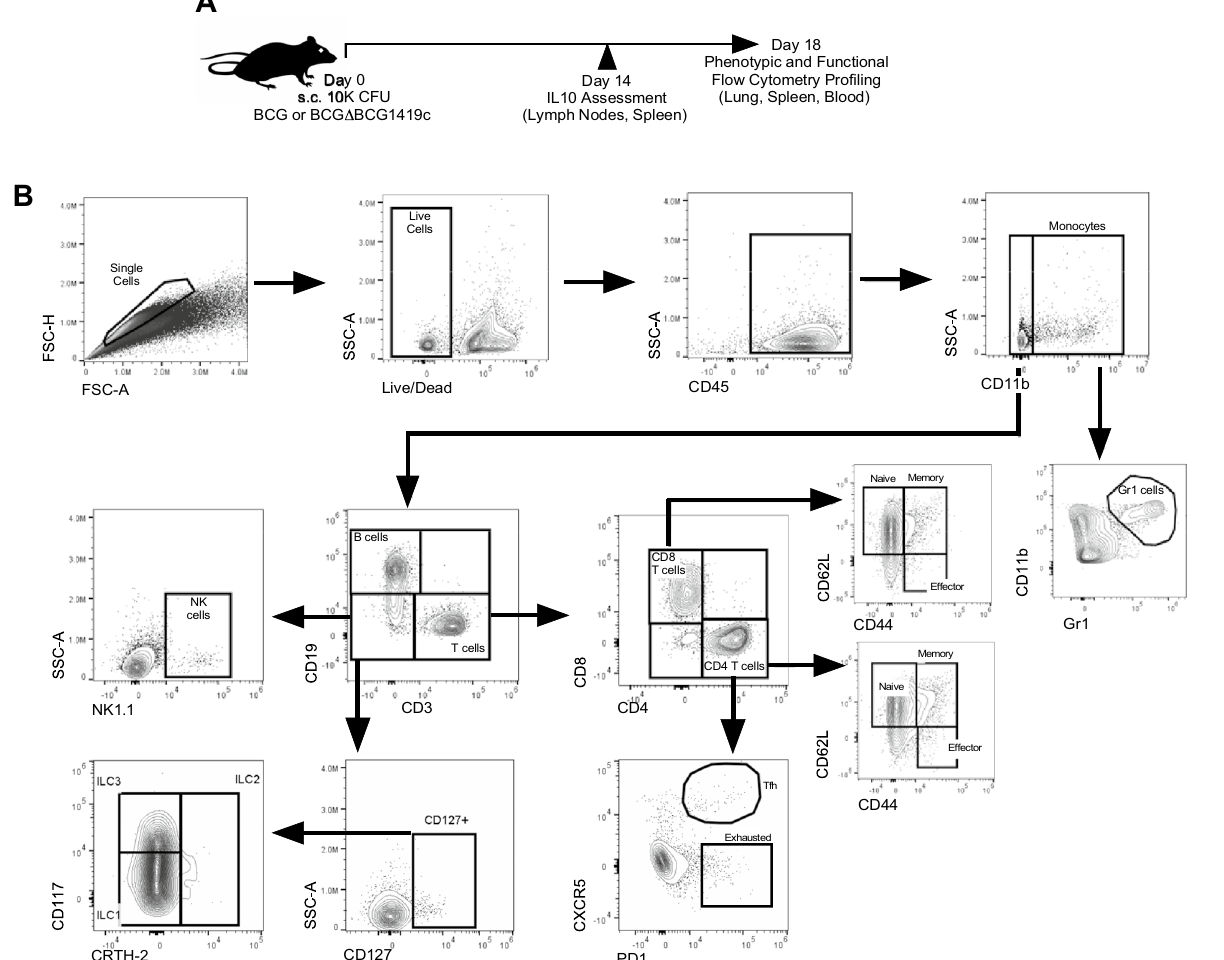
Figure 1. Overview of experiment. ( A ) Vaccination schedule and ( B ) gating strategy to identify innate and adaptive